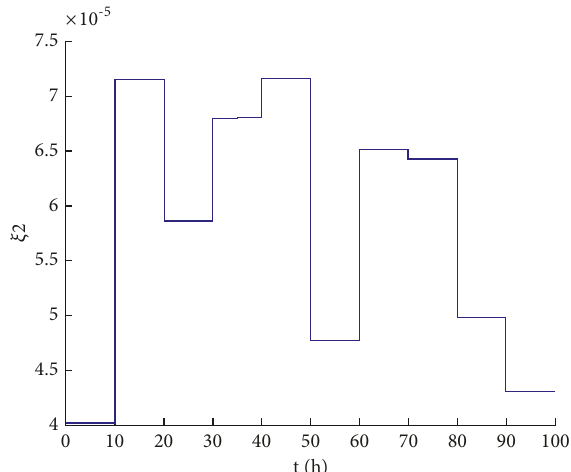
Figure 6: The dilution rate.